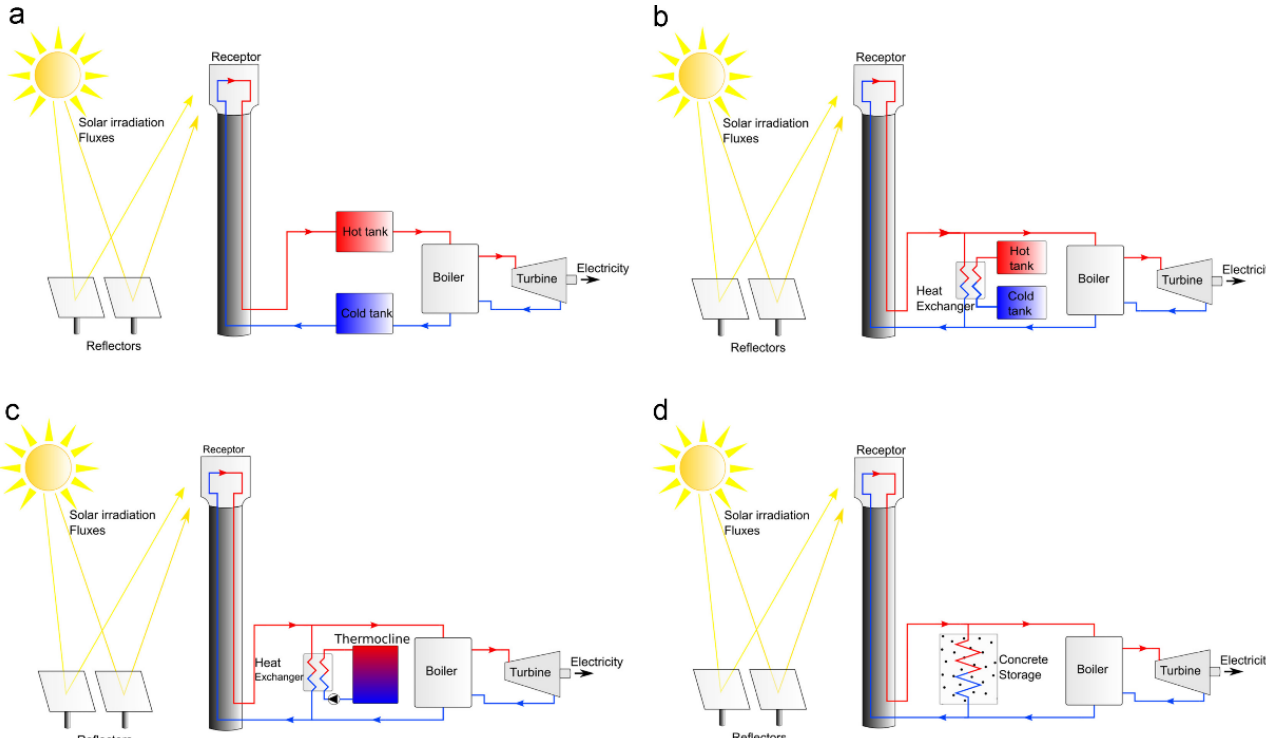
Figure 1. Integration concept of TES system in a solar thermal power plant [8]. ( a ) Active direct concept for two-tank TES integration; ( b ) active indirect concept for two-tank TES integration; ( c ) active indirect concept for single-tank thermocline TES integration; ( d ) passive concept for TES integration. Reprinted with permission from ref. [8]. 4 October 2021, Elsevier.